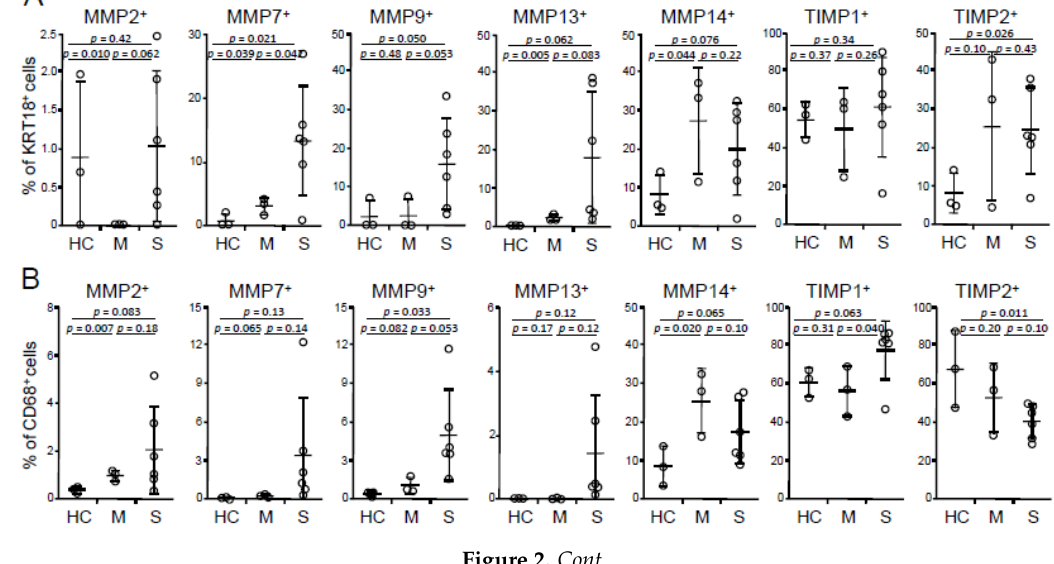
Figure 2. Expression of tissue factors in BALF cells. ( A , B ) Frequencies of MMP- and TIMP-expressing epithelial cells ( A ) and macrophages ( B ). ( C ) Abundances of MUCs in epithelial cells. ( D ) Frequencies of HAS-expressing epithelial cells. ( E , F ) Frequencies of tPA- and PAI-1-expressing epithelial cells ( E ) and macrophages ( F ). ( G ) Ratios of total tPA vs. PAI-1 and total uPA- vs. PAI-1-expressing cells. HC, healthy control ( n = 3); M, mild ( n = 3); S, severe ( n = 6). Mean and s.d. are shown; p values; unpaired t -test. 3.4. Severe COVID-19 Manifests Increased Expression of Mucin 1 (MUC1), HAS2, and PAI-1 Hypersecretion of MUCs is a common feature of many lung diseases, including viral infection, asthma, and COPD. Hypersecretion of MUCs was also reported in COVID-19 [32]. Of abundant mucins, MUC1 expression is upregulated (but did not reach signifi- cance) in epithelial cells of severe vs. mild COVID-19, whereas there were no differences in MUC4 and MUC16 between the two groups (Figure 2C). Hypersecretion of hyaluronic acid presents in severe COVID-19 [33,34]. Consistently, HAS2, but not HAS3, was upreg- ulated in severe cases (Figure 2D), whereas there were very few HAS1-expressing cells (data not shown). In addition to hyperproduction of MUC1 and hyaluronic acid, there were more epithelial cells producing tissue plasminogen activator (tPA) and PAI-1 in se- vere disease compared with mild disease (Figure 2E). Severe cases also had higher fre- quencies of PAI-1 + , but not tPA + macrophages (Figure 2F). Total tPA + to PAI-1 + (tPA/PAI-